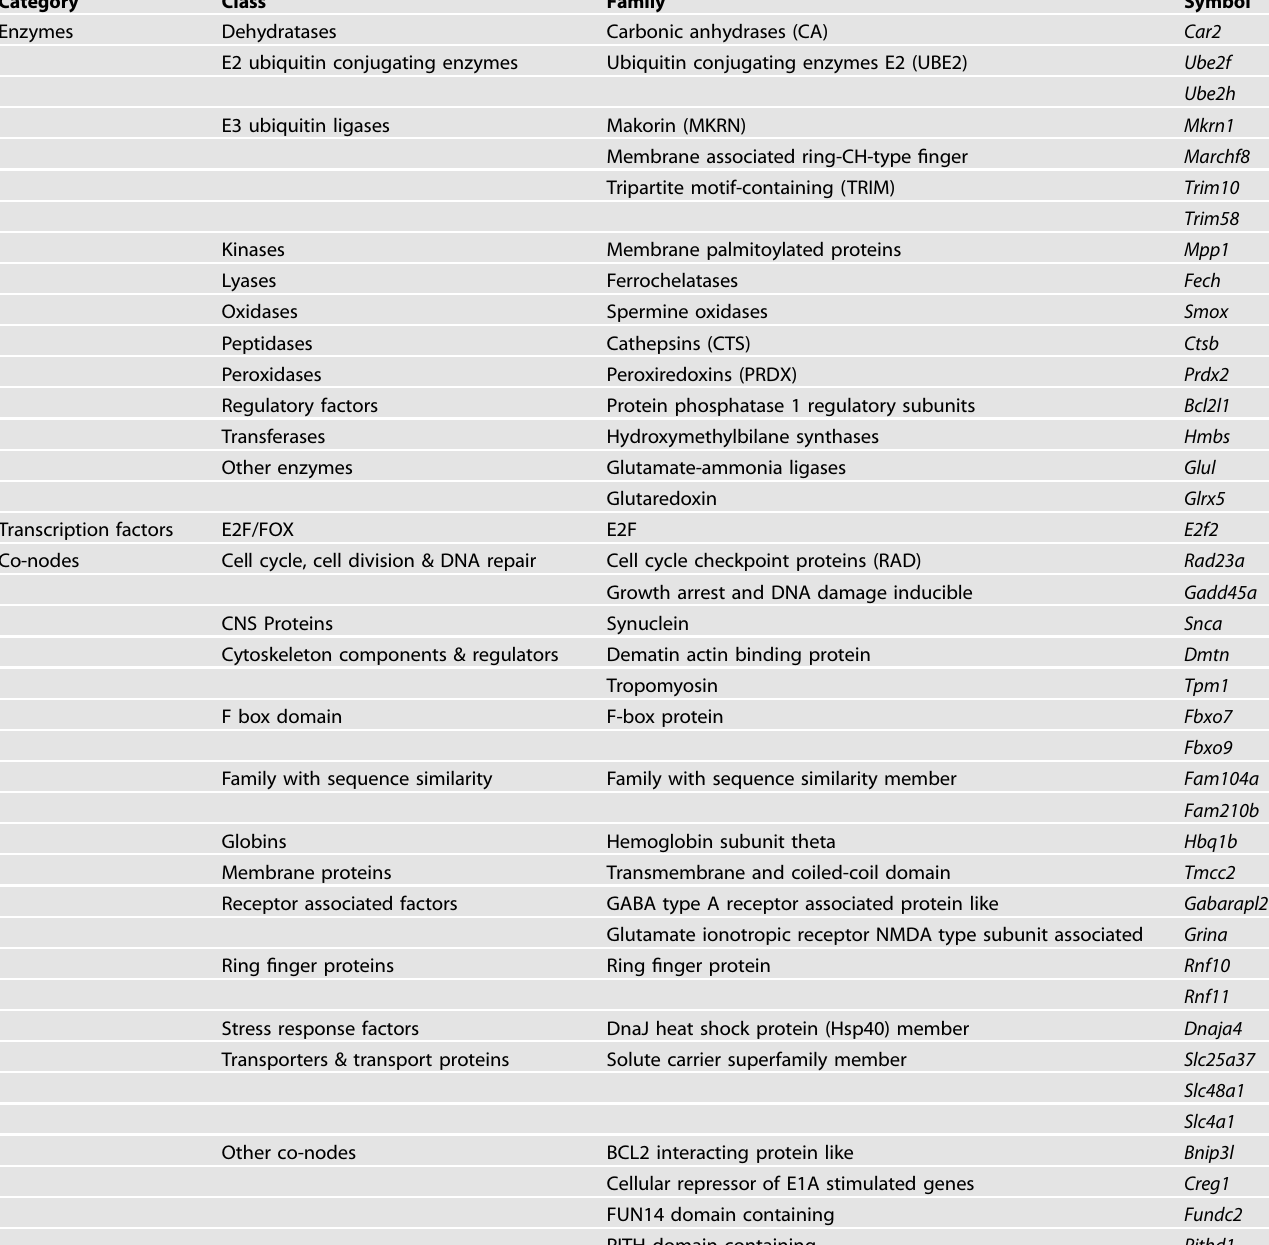
Table 2. Functional categorization of genes in common between the mouse AIWG-P gene set and the human HWG/BMI gene set.